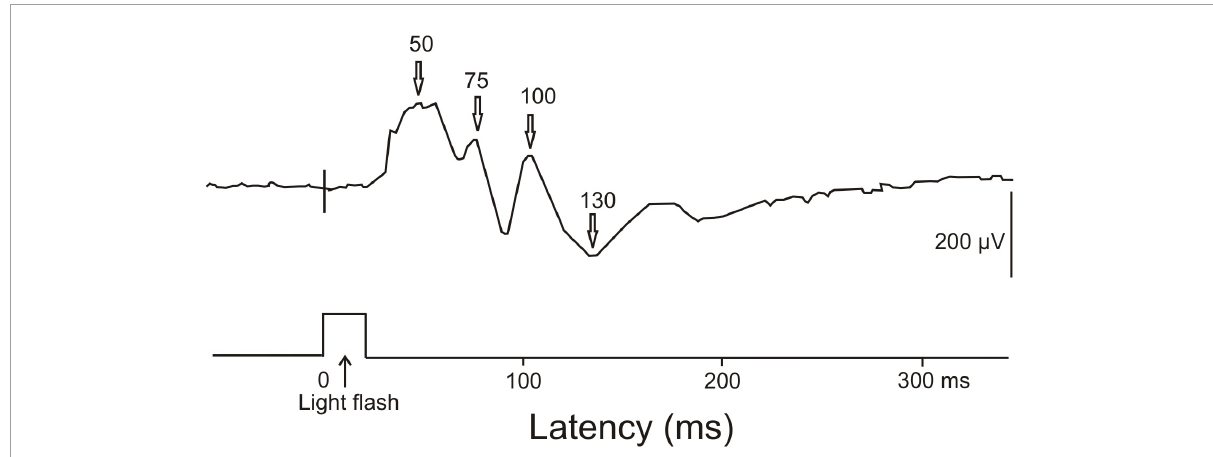
FIGURE6 ERP recorded from the central nervous system of a cuttlefish ( Sepia ) in response to a single light flash. The light flash had a duration of 20 ms. The ERP response showed main positivities at about 50, 75, and 100 ms latency and a negativity around 130 ms latency. [Modified from Bullock and Budelmann (1991); their Figure 2, lower